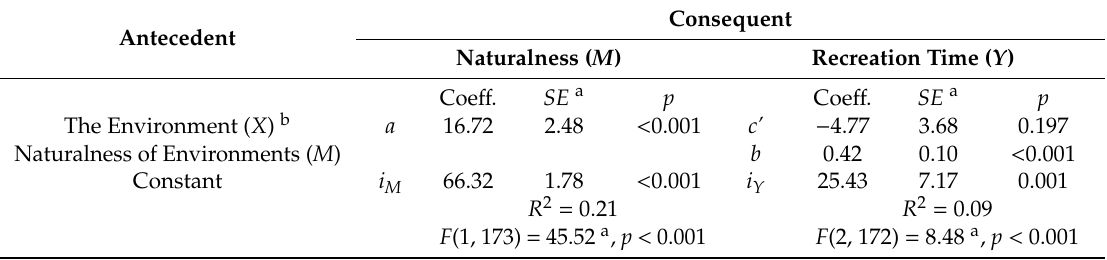
Table 2. Model coe ffi cients for the simple mediation for environments with animate soundscapes. Consequent Antecedent Table 2. Model coefficients for the simple mediation for environments with animate soundscapes. Naturalness ( M ) Recreation Time ( Y Consequent Antecedent Naturalness ( M )